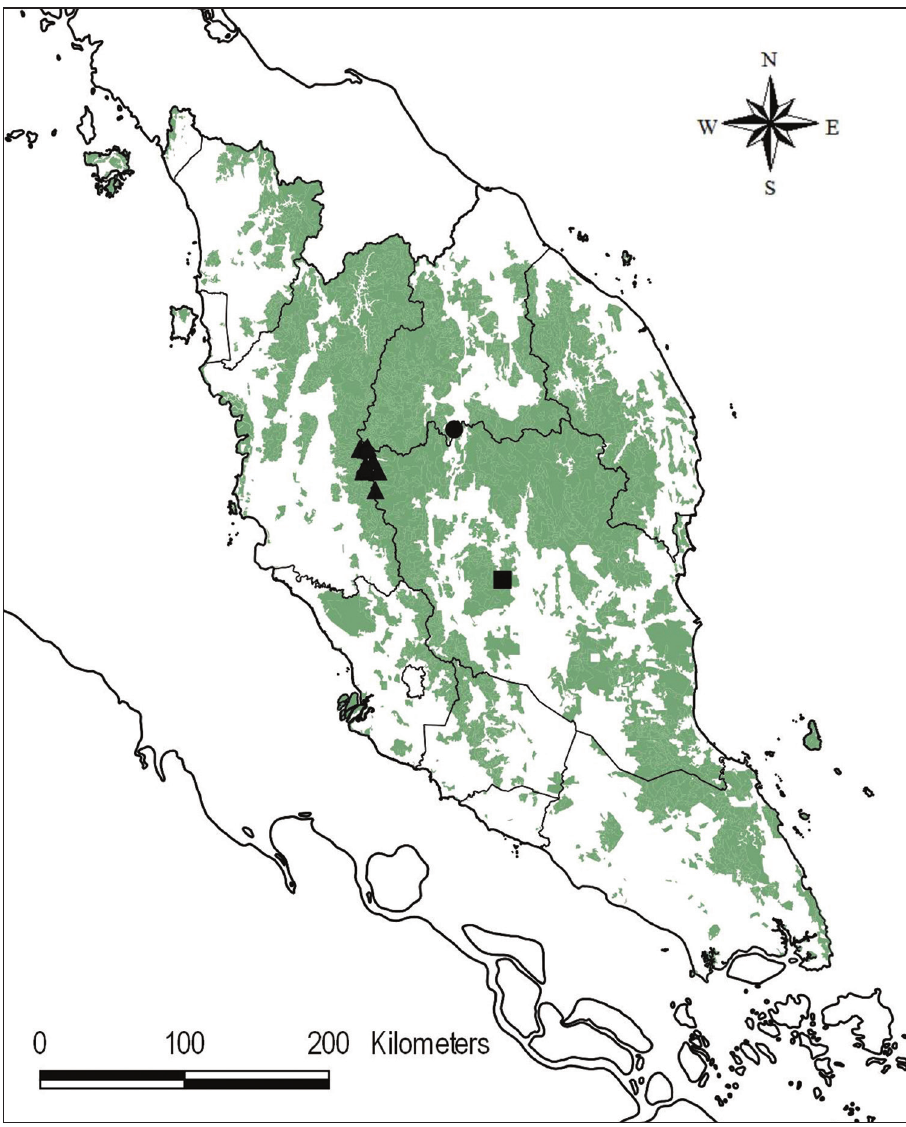
Map 1. Distribution of Ridleyandra merohmerea ( ● ), R. morganii ( ▲ ) and R. iminii ( ■ ) in Peninsular Malaysia. NFI III Courtesy of Forest Department Peninsular